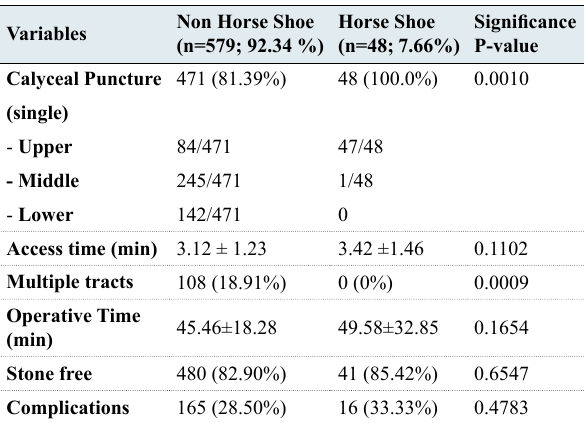
Table 3: Perioperative outcome among the patients undergoing